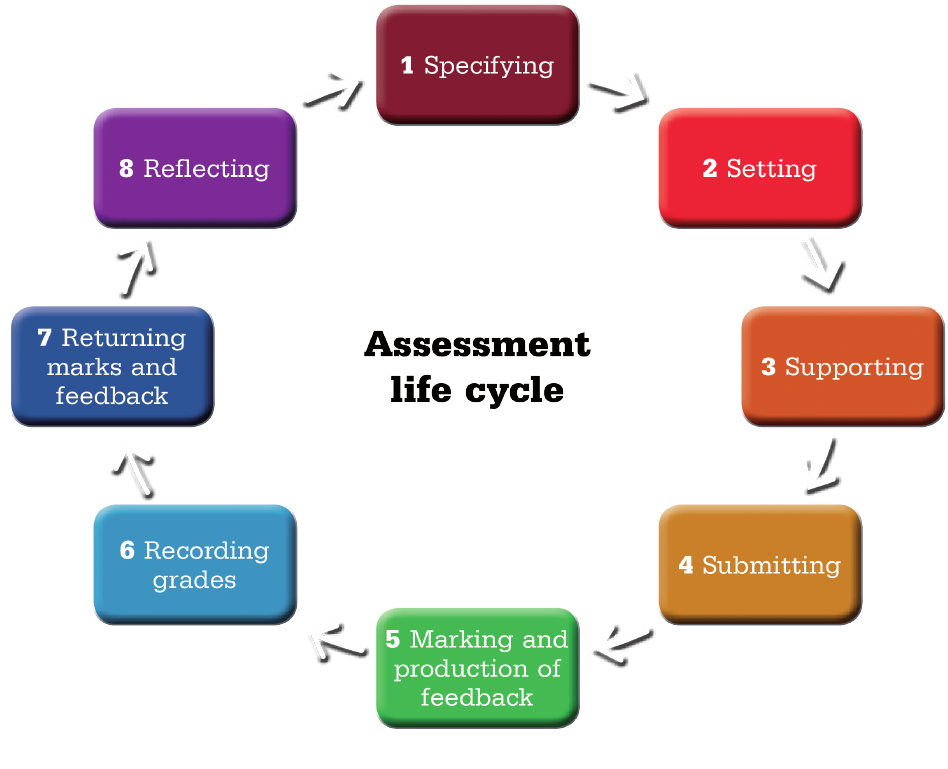
Figure 1: Assessment life